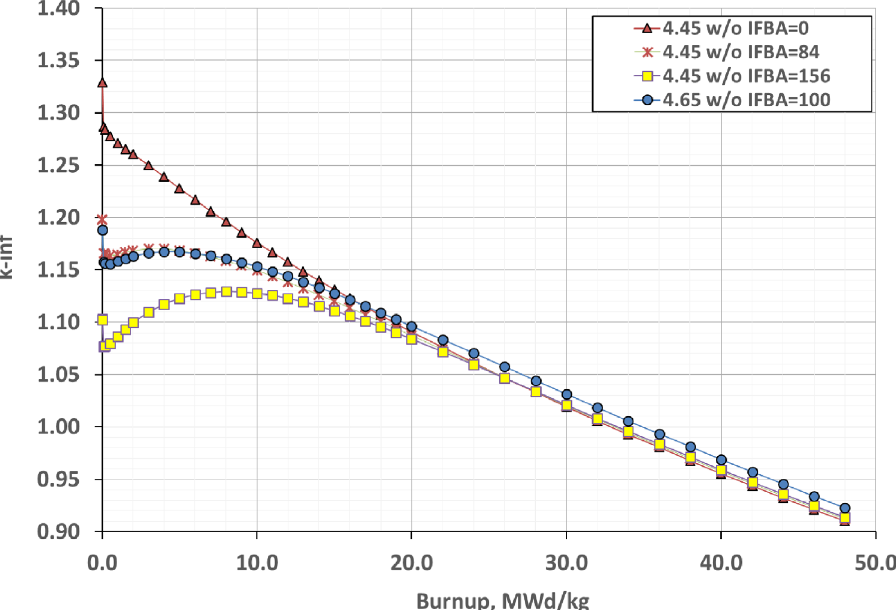
Fig. 4. Criticality curves for different IFBA loading patterns (note that k-inf initially increases with burnup as the burnable poison burns out).